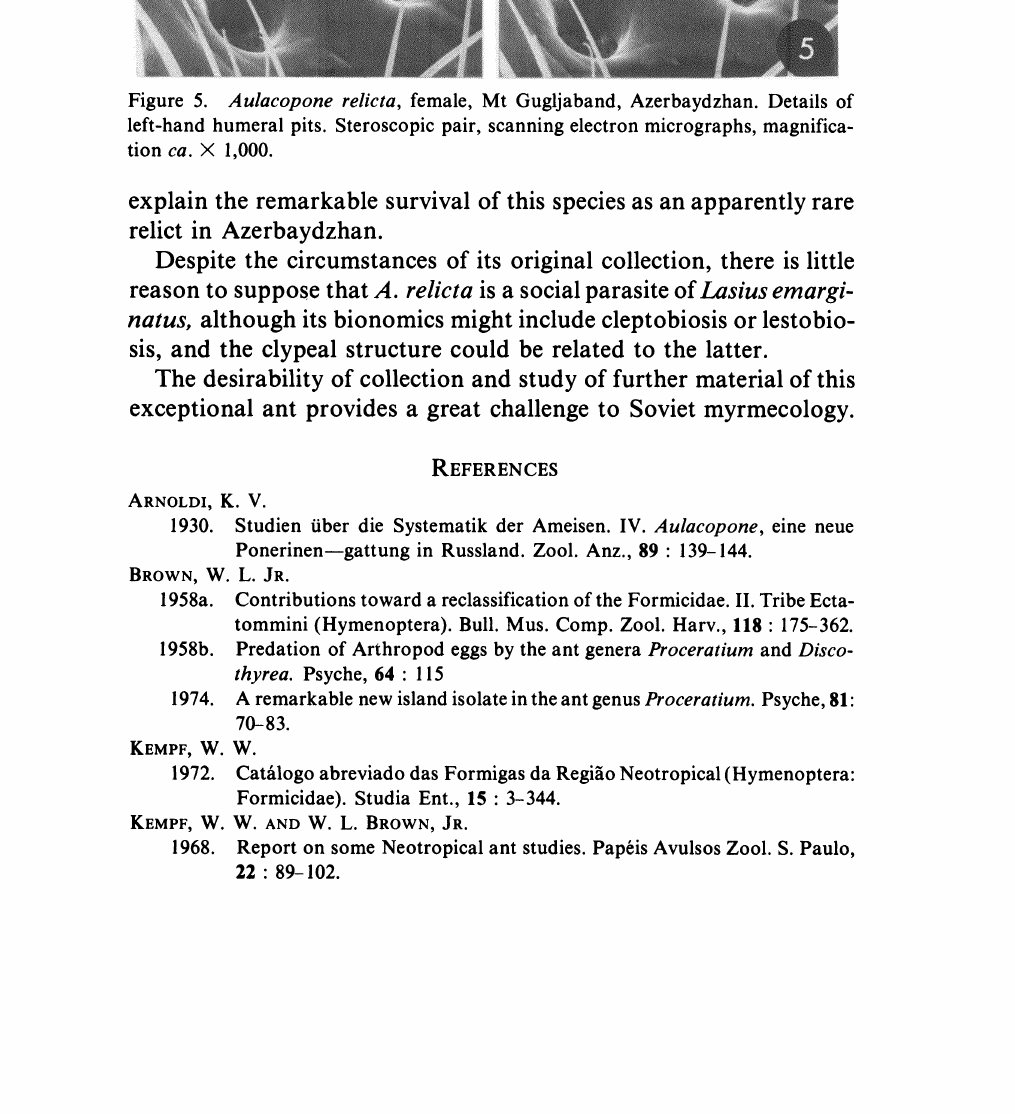
Figure 5. Aulacopone relicta, female, Mt Gugljaband, Azerbaydzhan. Details of left-hand humeral pits. Steroscopic pair, scanning electron micrographs, magnifica- tion ca.